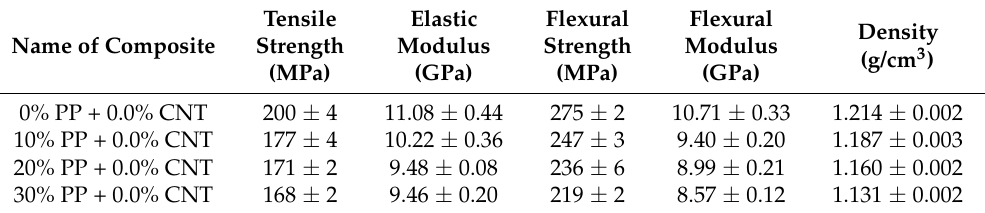
Table 3. Mechanical properties and densities of CF/PA6 composites with different polypropylene (PP)